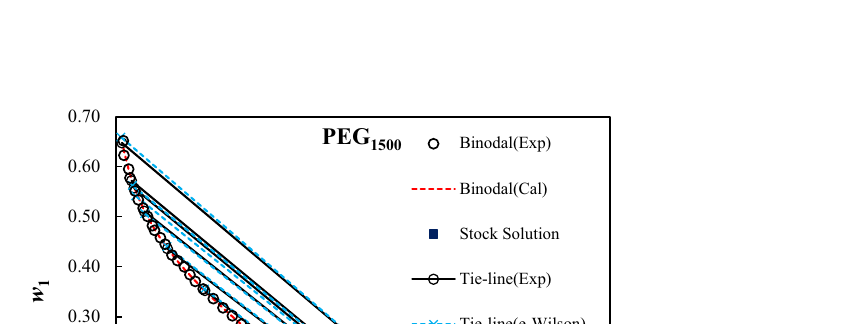
Figures 4. Experimental ( Exp ) and calculated ( Cal ) binodal curves using Merchuk equation, and tie-line composition using e-Wilson model for PEG 1000 (1) + trilithium citrate (2) + water (3) ATPSs at T = 298.15 K, and P = 101 kPa.